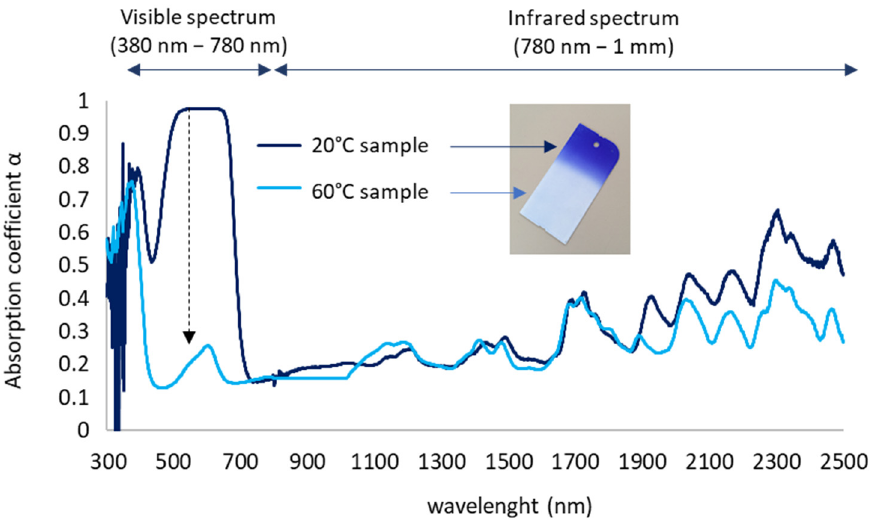
Figure 5. Absorption coefficient of paint measured at 20 °C and 60 °C. The black arrow on the graph shows a high variation in the coefficient in the visible spectrum.